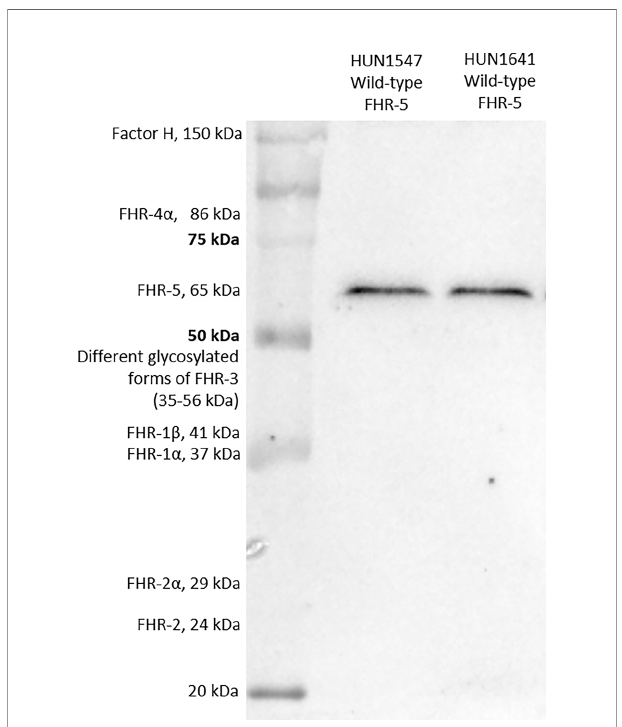
FIGURE 1 | Factor H-related protein 5 (FHR-5) on Western blot. Two serum samples obtained from patients with wild-type FHR-5 protein were